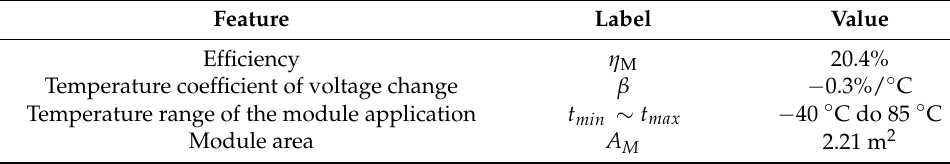
Table 2. Technical characteristics of the Jetion module 450 W JT450SGH [28]. Feature Label Value Efficiency η M 20.4% Temperature coefficient of voltage change